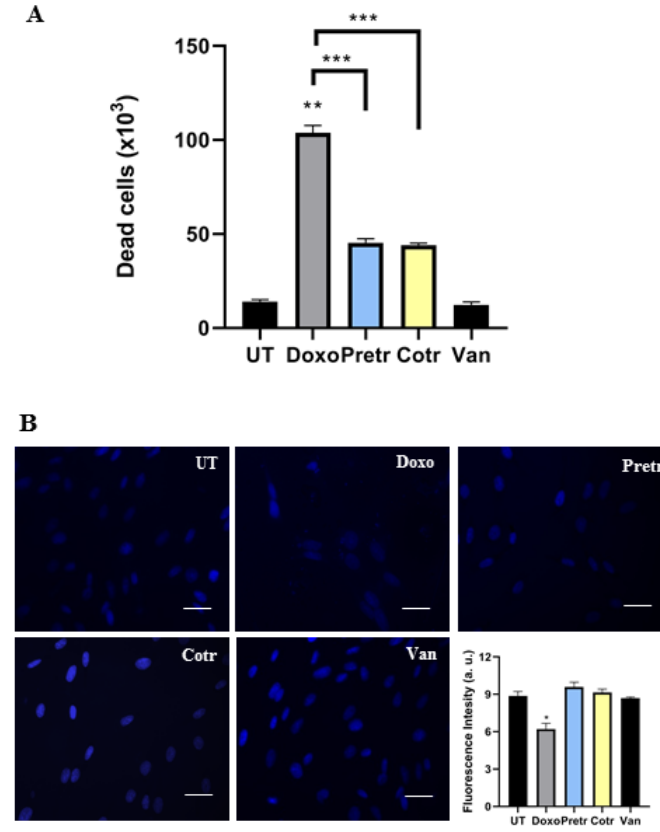
Figure 3. Effect of vanillin on doxo-induced cell death and nuclear alteration. ( A ) Dead cells number were evaluated by Trypan Blue assay in H9c2 cells exposed to 20 µ M doxo for 24 h, pretreated (Pretr) and co-treated (Cotr) with 100- µ M vanillin. UT—untreated cells; doxo—cells exposed to 20- µ M doxo; Van—cells exposed to 100- µ M Van. Scale bar represents 50 µ m. Data represent the average of three independent experiments ± SD; ( B ) representative fluorescence images of cells stained by DAPI nuclear staining. The fluorescence intensity was estimated by Image J software. *: p < 0.05; **: p < 0.01; ***: p < 0.001 by two-way ANOVA. Other experimental details are described in Materials and Methods section.